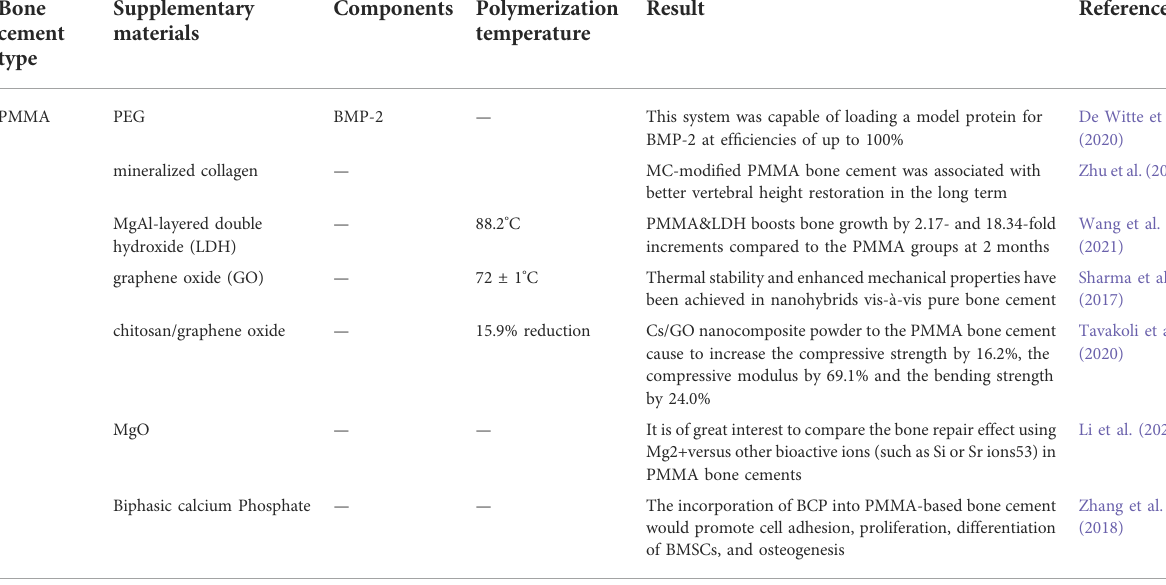
TABLE 1 Improved PMMA bone cement promotes bone